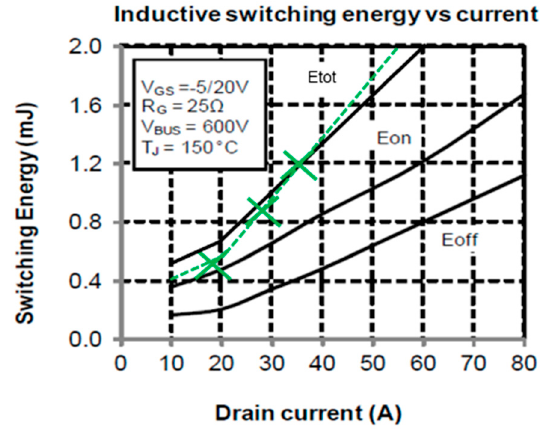
Figure 18. Switching energy comparison: manufacturer data and experimental measurements (green dots).